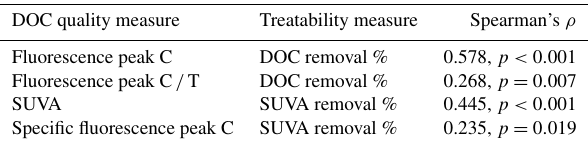
Table 3. t tests for pre- and post-incubation peat samples (signifi- cant differences highlighted in